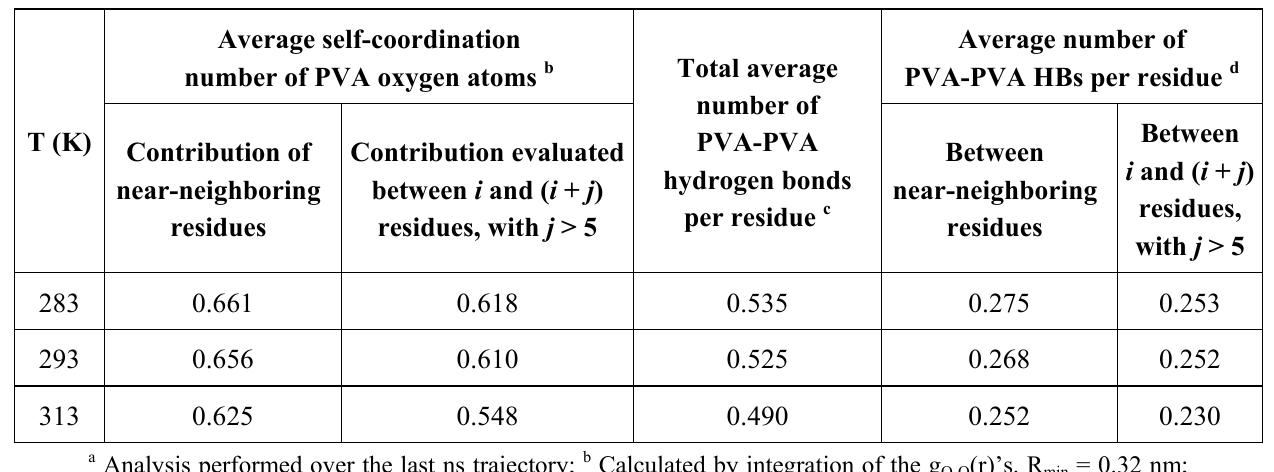
Table 1. Intramolecular connectivity of PVA a